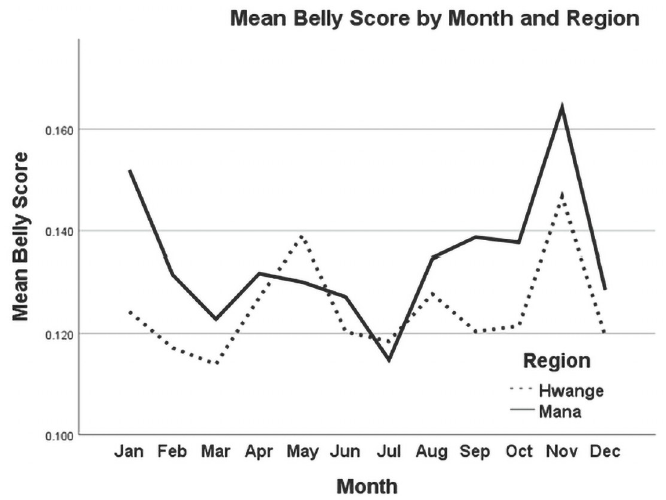
Fig 4. Monthly variation in Lycaon pictus belly score means between Hwange and Mana Pools regions, Zimbabwe.